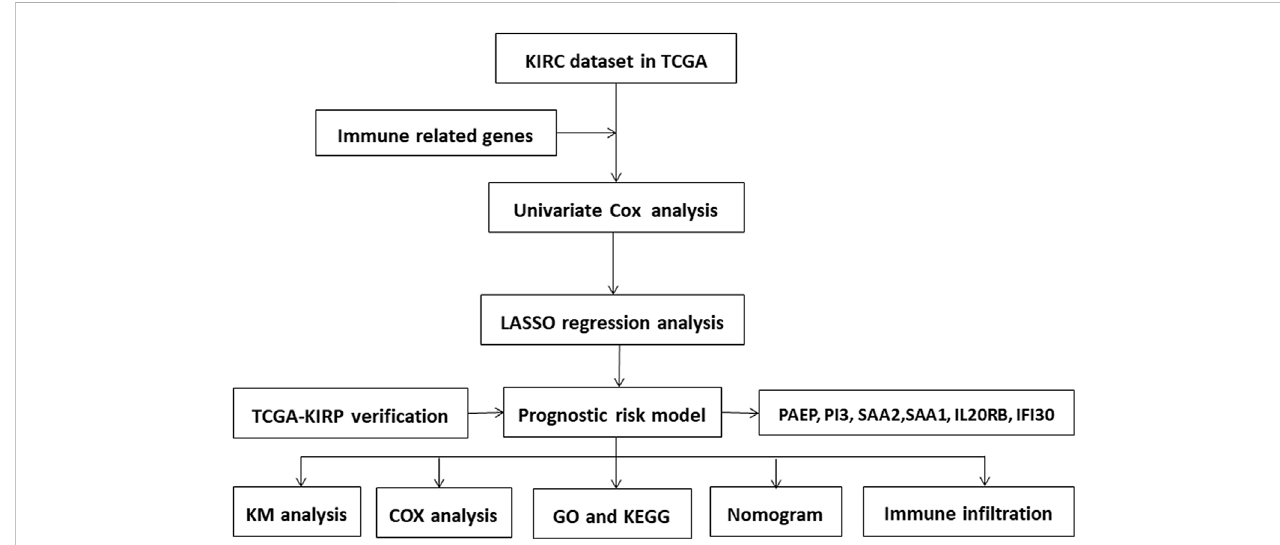
FIGURE 1 Flow chart of steps followed for data collection and analysis in this study.